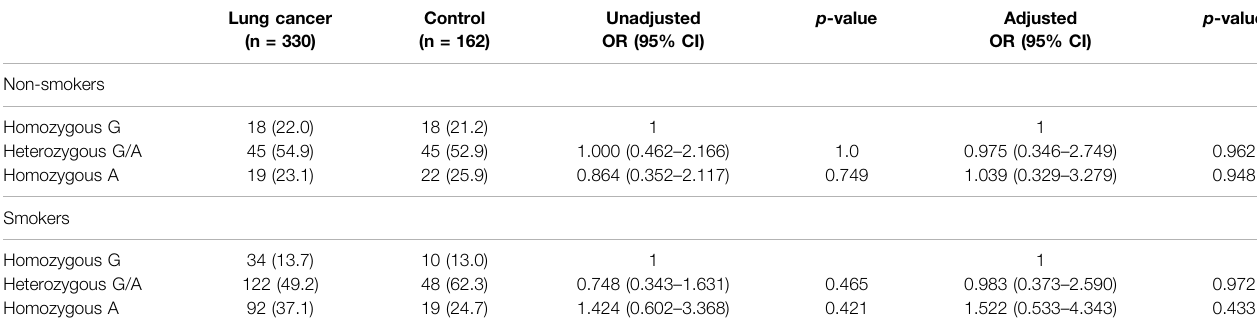
TABLE 4 | The genotype distribution of COX-2 – 1195G/A gene strati fi ed by smoking status.